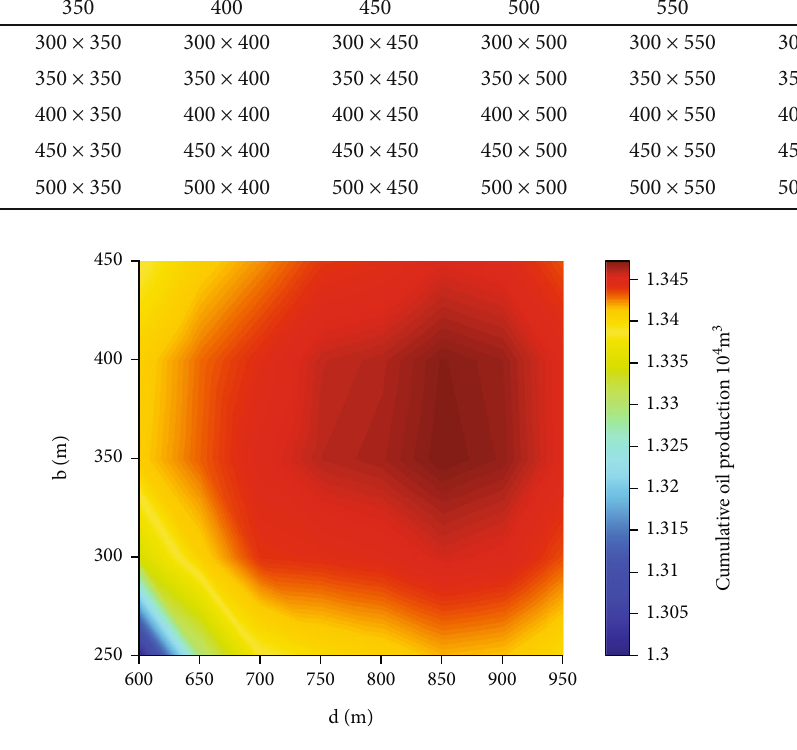
Figure 6: Cumulative oil production for the scenarios with di ff erent well spacing (inverted 5-spot well pattern).